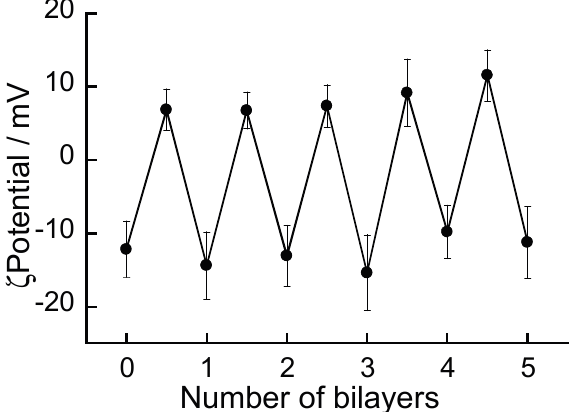
Figure 3. ζ -Potentials of (PAH/PSS) The average values of ζ -potentials for ca . 50 particles are plotted with standard deviations. The outermost surface of the microspheres was covered with PSS for the integer bilayer